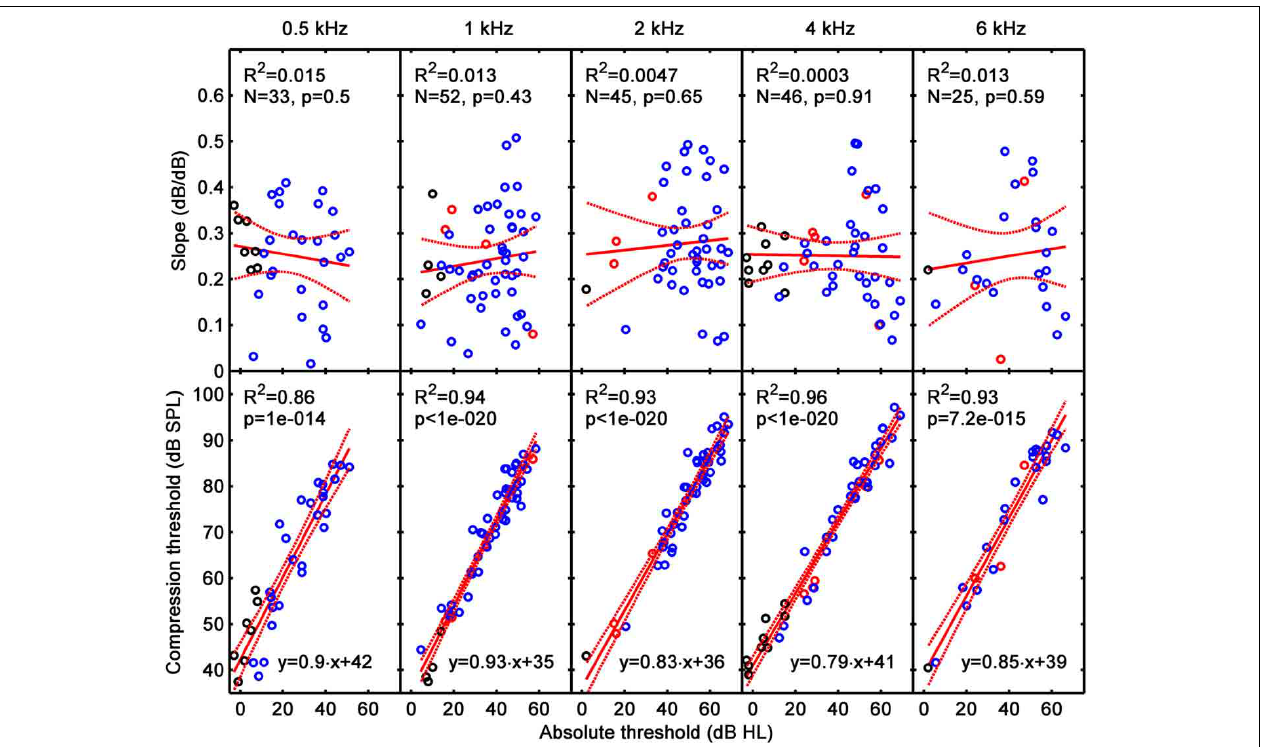
FIGURE 9 | Correlation of average slope (i.e., the slope of the I/O over the compressive segment) (top) and compression threshold (bottom) with absolute threshold. Each column is for a different test frequency, as indicated by the column title. Results for the present listeners are depicted as blue symbols; results for NH listeners and for listeners with mild-to-moderate